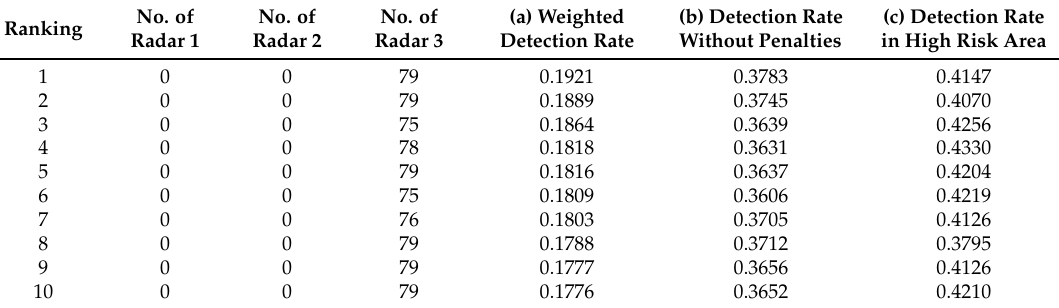
Figure 5. Sensor deployments of the best samples (ranking numbers on the top left). Circles represents each radar’s detection range. each radar’s detection range. Table 3. Best 10 sensor configurations (ordered by (a) detection rate including